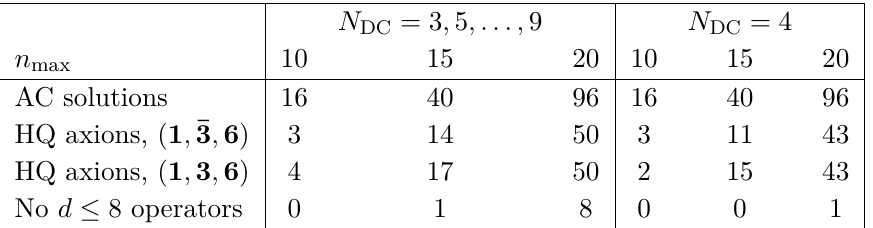
= 12 and integer charges Table 8 . Number of ( 1 , ¯3 , 6 ) and ( 1 , 3 , 6 ) QCD models with ∆ (cid:8)(cid:8) PQ satisfying | p . Models are found through a numerical scan of the parameter space for i | , | q i | ≤ n max different values of n and 3 ≤ N 9 . The counting is made identifying solutions that are max DC ≤ equal up to an overall factor or by exchanging p . The first row indicates the total number of i ↔ q i independent solutions of the Anomaly Cancellation (AC) conditions of eq. (5.1), while the following rows list how many of these solutions yield High Quality (HQ) models. The last row shows the number of models with no operators of dimension d ≤ 8 with a non-trivial flavour